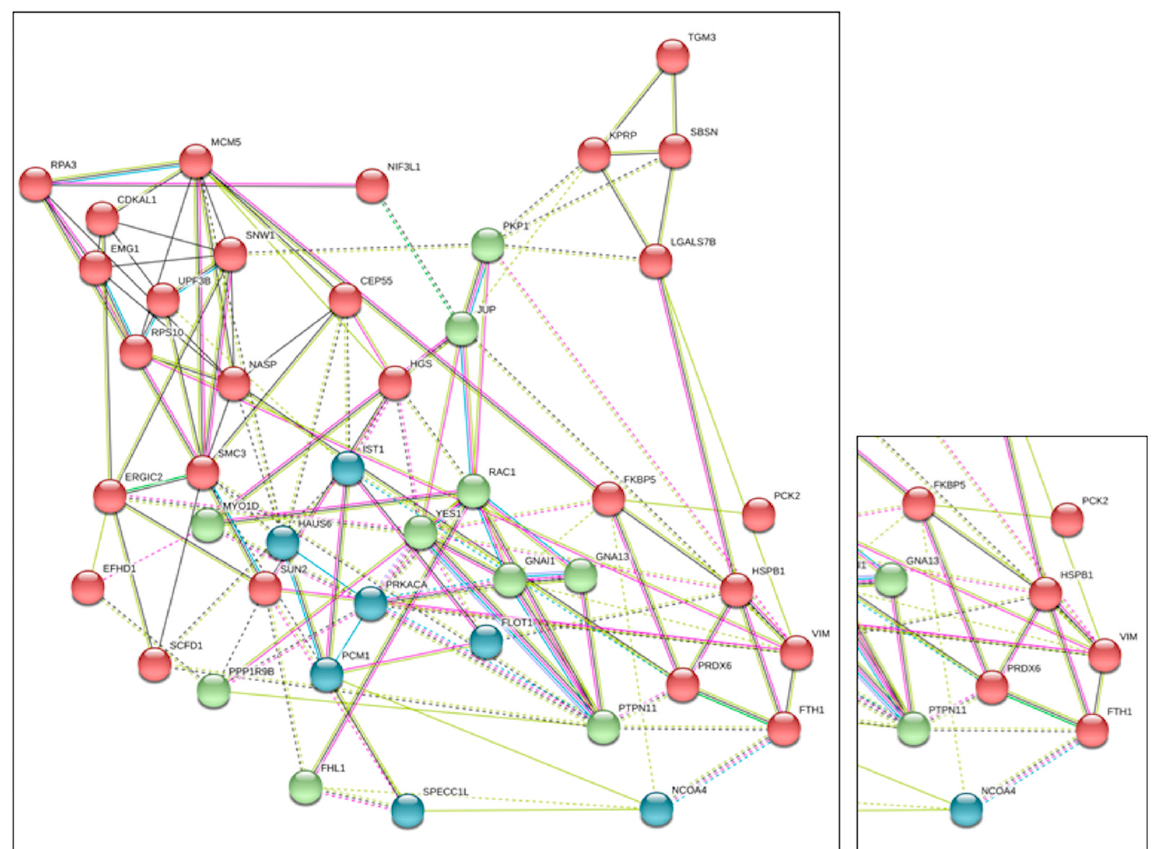
Figure 1. String Interaction Analysis: In silico interaction analysis by String (https://string-db.org/ (accessed on 13 October 2022)) suggests putative interaction of FTH1 and PRDX6.